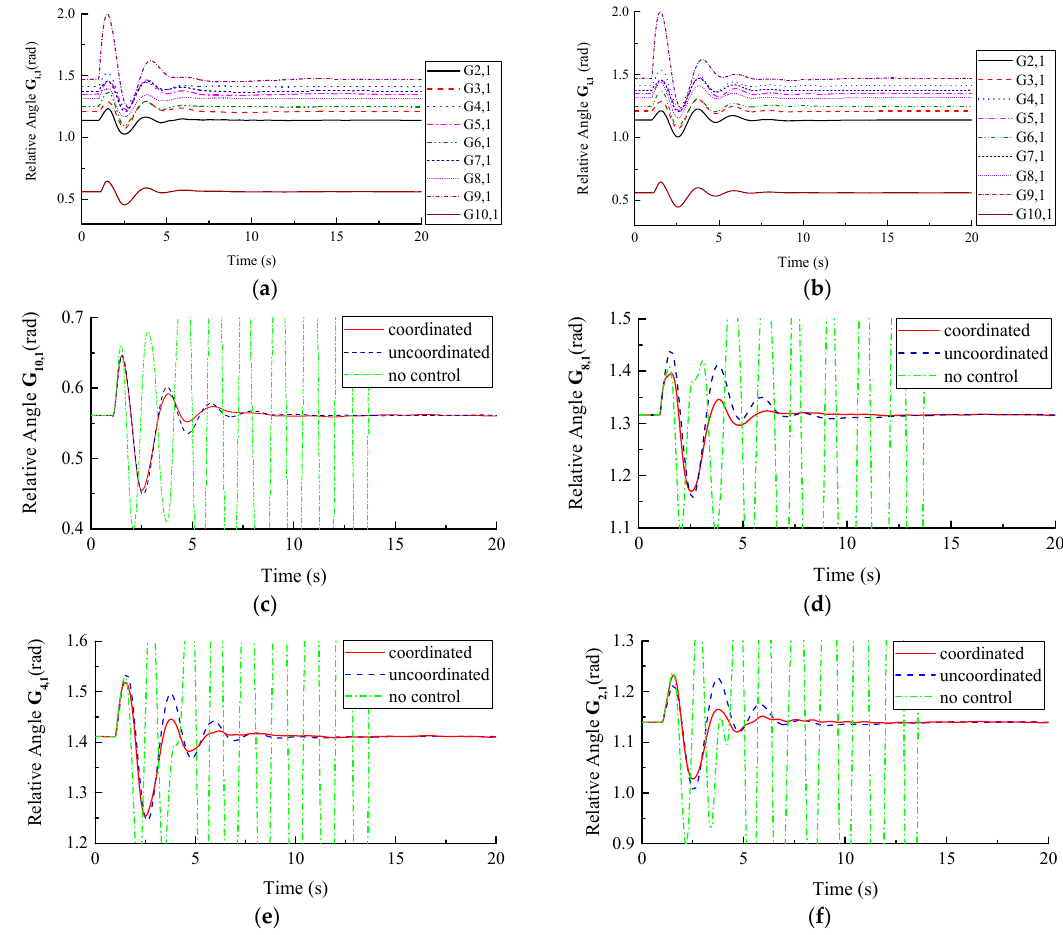
Figure 16 . Relative power angle response of synchronous generators with different coordinated damping controllers. ( a ) Coordinated damping controllers; ( b ) Uncoordinated damping controllers; ( c ) G 10,1 response under different control strategy; ( d ) G 8,1 response under different control strategy; ( e ) G 4,1 response under different control strategy; and ( f ) G 2,1 response under different control strategy.